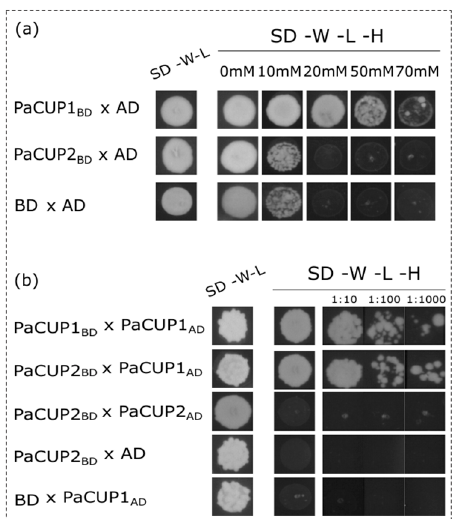
Figure 8. Yeast two-hybrid analysis to verify the interaction between the P. aphrodite PaCUP1 and PaCUP2 proteins. To check for the presence of plasmids, after double transformations, yeasts were grown in absence of tryptophan and leucine (SD-W-L medium); to verify the protein interactions, yeasts were grown in a medium lacking tryptophan, leucine, and histidine (SD-W-L-H medium). ( a ) Auto-activation experiments using the recombinant vector pGBKT7 containing the coding se- quence of PaCUP1 or PaCUP2 and the empty vector pGADT7. Double transformation with the pGADT7 and pGBKT7 empty vectors are the negative control. ( b ) Interaction of the PaCUP1 and PaCUP2 proteins. 1:10, 1:100, and 1:1000 were the dilution factors applied to the yeast inoculation. AD, GAL4 activation domain; BD, GAL4 DNA-binding